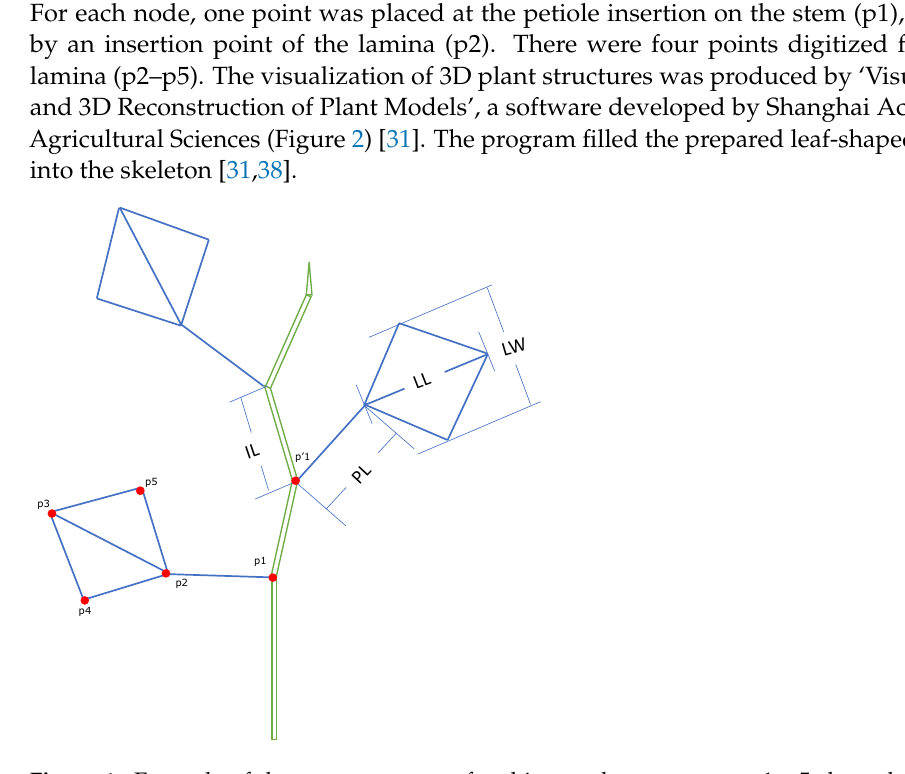
Figure 1. Example of the measurements of architectural parameters. p1–p5 show the positions of digitization of a phytomer unit of cucumber and its leaf geometry in a defined sequence. p’1 indicates the start point of the next measured phytomer. Each phytomer consists of four architectural parameters: LW represents the leaf width (cm); LL represents the leaf length (cm); PL represents the petiole length (cm); IL represents the internode length